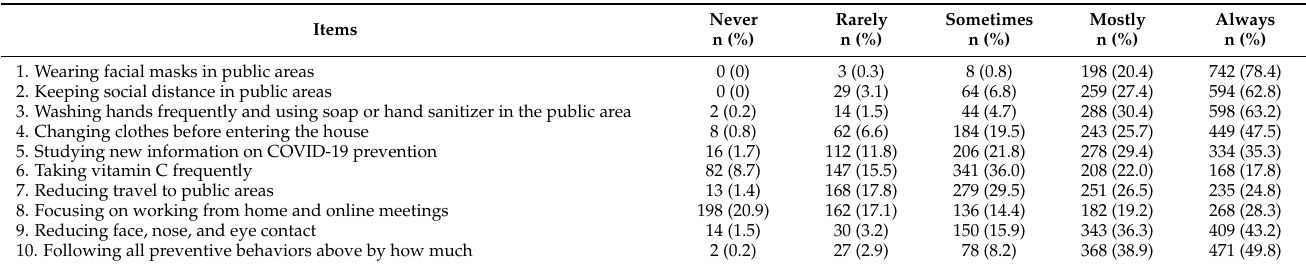
Table 5. Preventive behavior toward